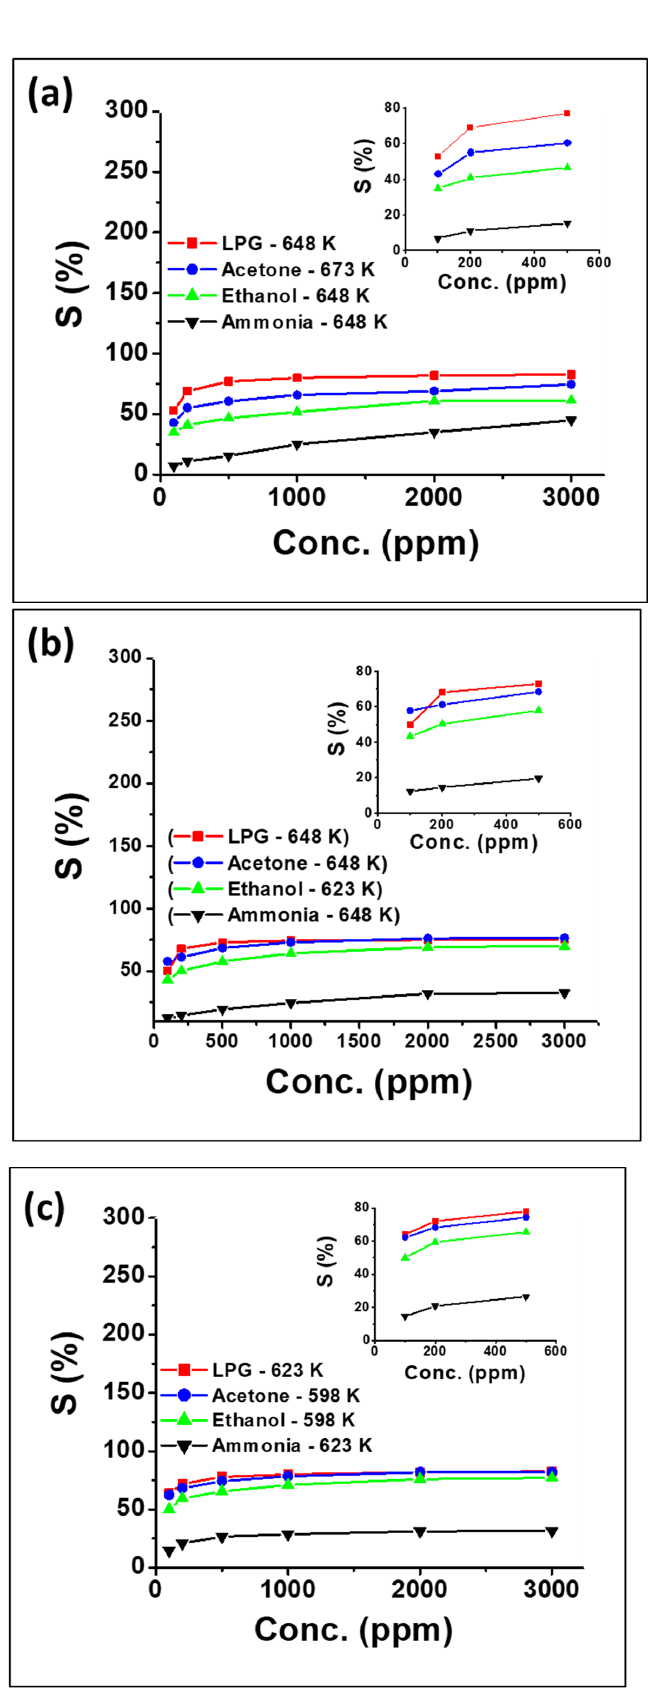
Figure 6. Gas response as a function of concentration of test gases at optimum operating temperature of as-prepared ferrites MgFe 2-x O 4- δ , ( a ) x = 0, ( b ) x = 0.05, and ( c ) x = 0.1, respectively. Figure 7 shows the selectivity studies of the developed MgFe 2 O 4 ferrite. The graph clearly exemplifies the LPG selectivity, along with the potential applicability in acetone, methanol, and ammonia sensing. Its response value (S%) reaches 78% for LPG, 76% for acetone, 60% for ethanol, and 28% for ammonia at a 1000 ppm gas concentration with an operating temperature of 648 K. Figure 7. Selectivity test of the developed MgFe 2 O 4 . In the studies on response and recovery times for test gases, the non-stoichiometric sensor (x = 0.1) showed a short response and recovery times of 9 and 19 s, respectively, for acetone which is noticeably less than the other two compositional sensors. This is at- LPG